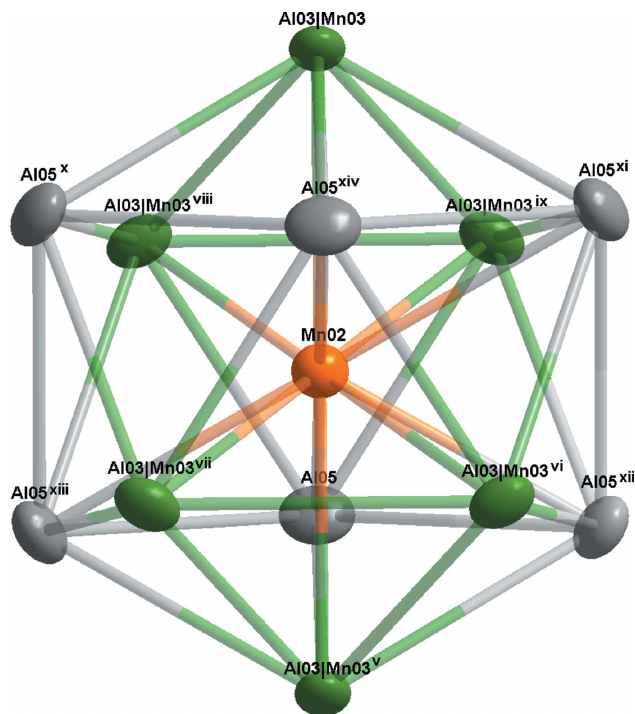
Figure 2 The environment of the Mn02 atom. Displacement ellipsoids are given at the 90% probability level. Symmetry codes: (v) (cid:3) x + 4/3, (cid:3) y + 2 (vi) y + 1 , (cid:3) x + y + 2 , (cid:3) z + 5 ; (vii) x (cid:3) y + 1 3 3 3 y , z ; (ix) (cid:3) x + y + 1, (cid:3) x + 1, z ; (x) (cid:3) x + y + 1 x (cid:3) y + 2 , z + 2 ; (xii) x (cid:3) y + 1, x , (cid:3) z + 1; (xiii) y , (cid:3) x + y , (cid:3) z + 1; (xiv) 3 3 (cid:3) x + 1, (cid:3) y + 1, (cid:3) z + 1.